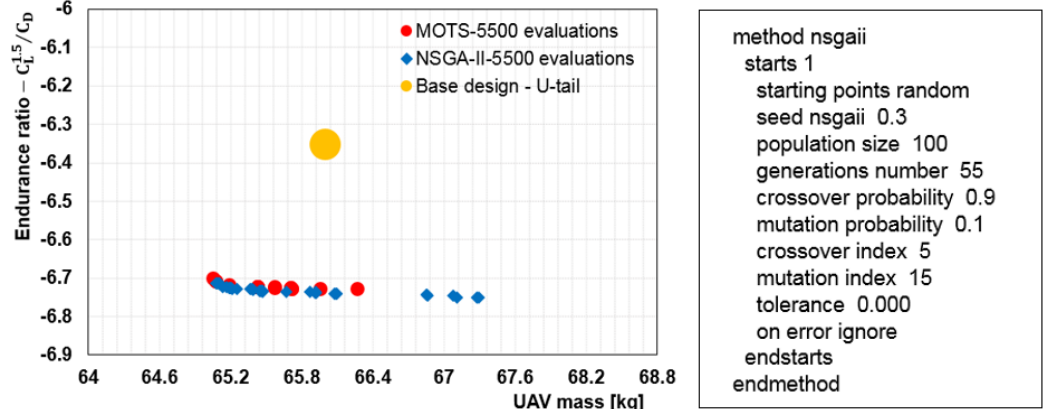
Figure 11. Left panel: comparison of the optimisation results obtained using MOTS and NSGA-II for 5500 evaluations. Right panel: the parameter setting for NSGA-II.